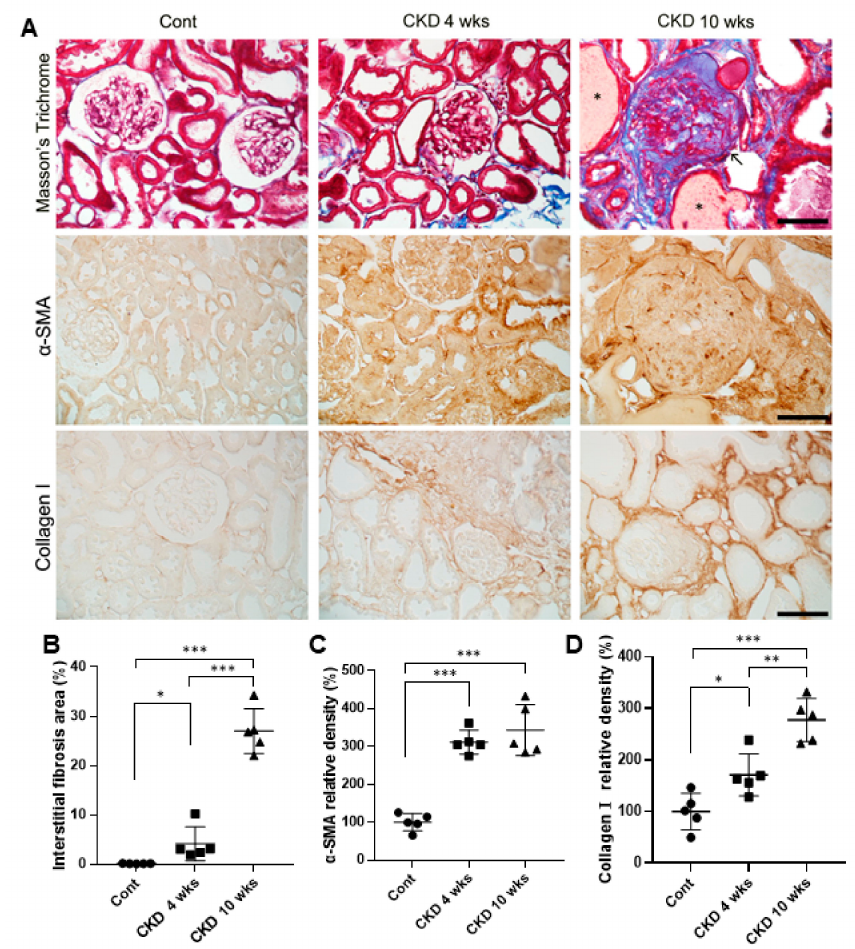
Figure 2. Masson’s trichrome staining, and expression of α -SMA and collagen I in the kidneys of CKD and wild-type rats. Masson’s trichrome staining revealed progressive interstitial fibrosis at CKD 4 and 10 weeks more than in the wild-type ( A , B ). 10 weeks-recovered CKD rat models showed glomerulosclerosis collagen deposition in glomeruli (arrows) and injured tubules (*). Mor- phometric analysis for relative interstitial fibrosis: in CKD rats, increased α -SMA and collagen I immunoreactivities of the interstitium when compared with wild-type rats ( A , C , D ). In particular, densitometry of collagen I analysis were more enhanced at CKD 10 weeks rats than 4 weeks rats ( D ). Scale bar = 25 µ m. Data are presented as means ± standard errors of the mean. * p < 0.05, ** p < 0.01, and *** p < 0.001, one-way analysis of